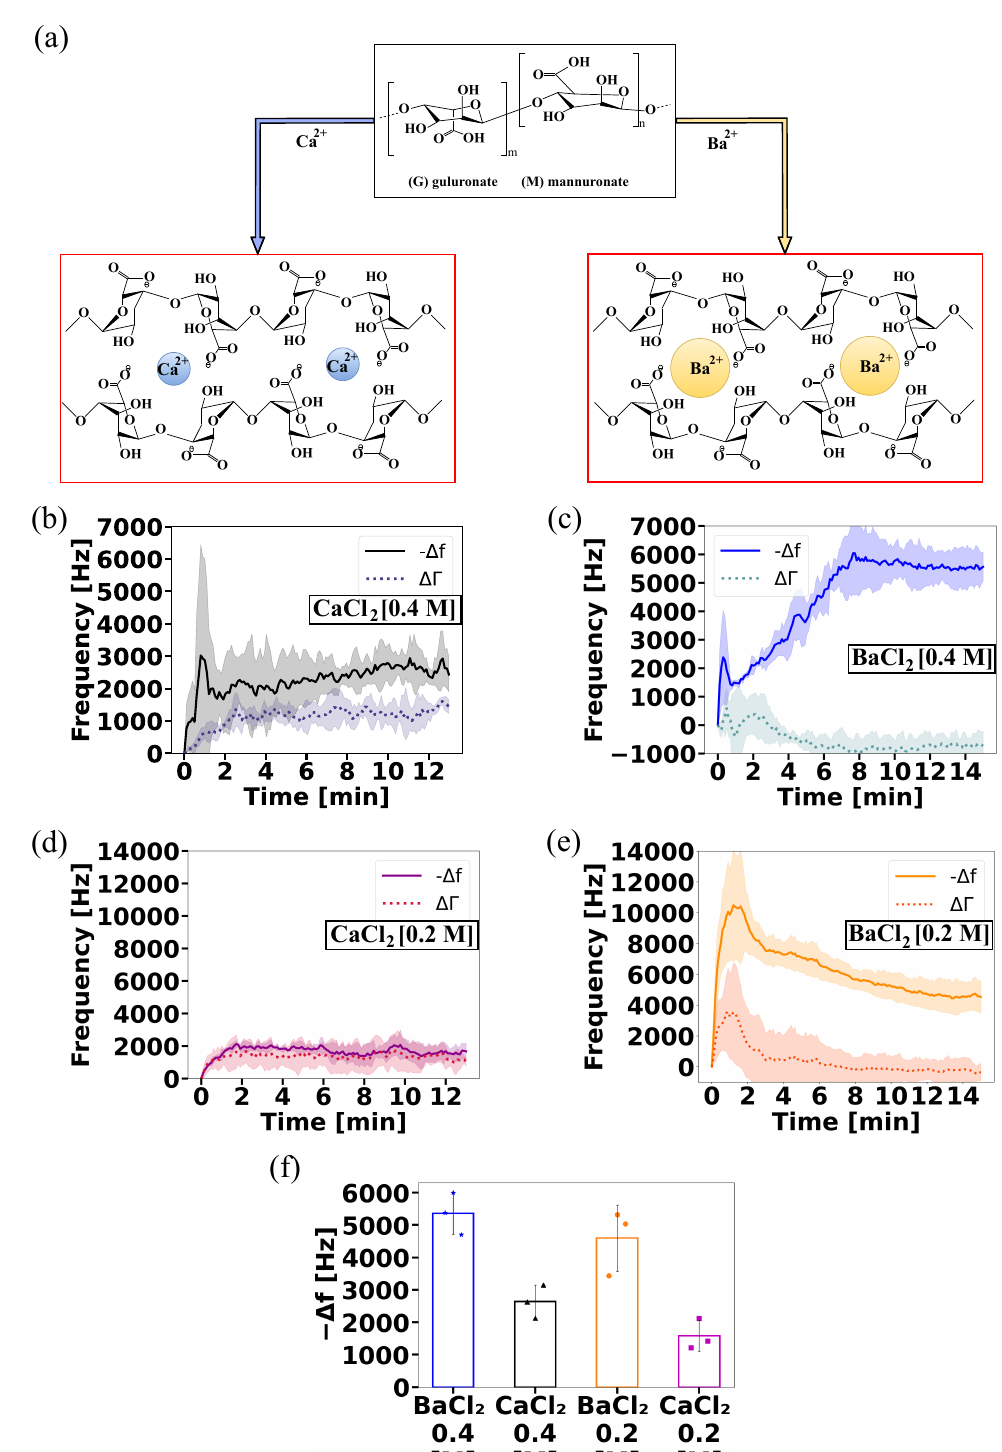
Figure 4. ( a ) Structure of alginate reacting with Ca 2 + and Ba 2 + . Characterisation of alginate gel for- mation using two drivers with two concentrations using ViSQCT sensor @ 10 MHz. Time-dependent evaluation of ∆ f and ∆Γ : ( b ) CaCl 2 (0.4 M). ( c ) BaCl 2 (0.4 M). ( d ) CaCl 2 (0.2 M). ( e ) BaCl 2 (0.2 M). The shaded area denotes the standard deviation obtained from measurements of n = 3 independent samples. ( f ) Comparison of ∆ f plateaulike stage for the four